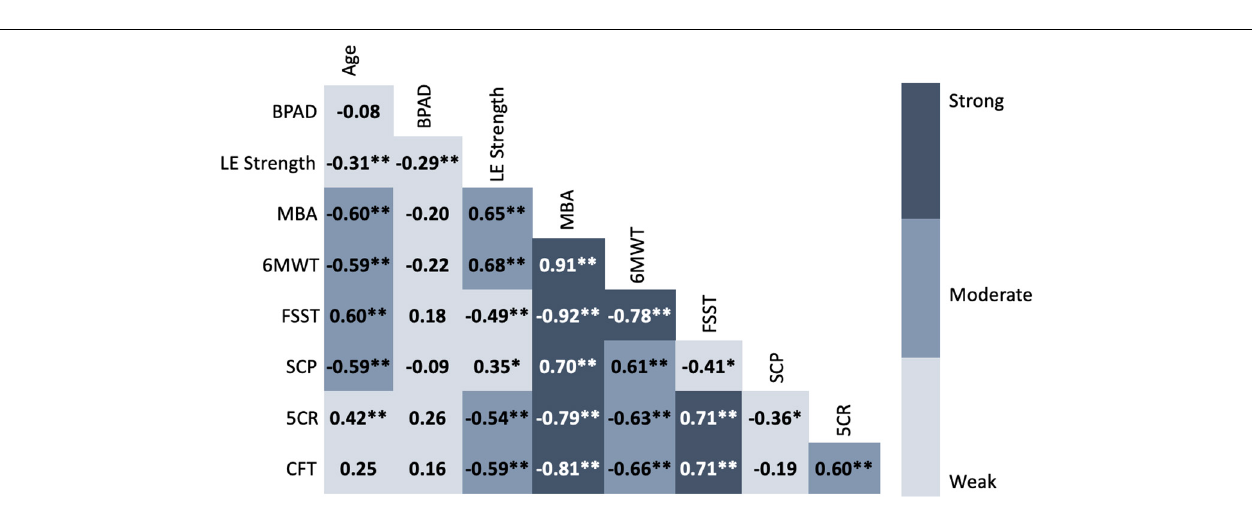
FIGURE 3 | Correlation matrix of chronological age, brain-predicted age difference, normalized leg strength and functional performance. Values represent Pearson’s r for each bivariate correlation. Weak = 0.00–0.49 , Moderate = 0.50–0.69, Strong = 0.70–1.0 (Jurs et al., 1998). BPAD, brain-predicted age difference; LE, lower extremity; MBA, mobility battery assessment; 6MWT, six-minute walk test; FSST, four square step test; SCP, stair climb power; 5CR, five times chair rise; CFT, complex functional